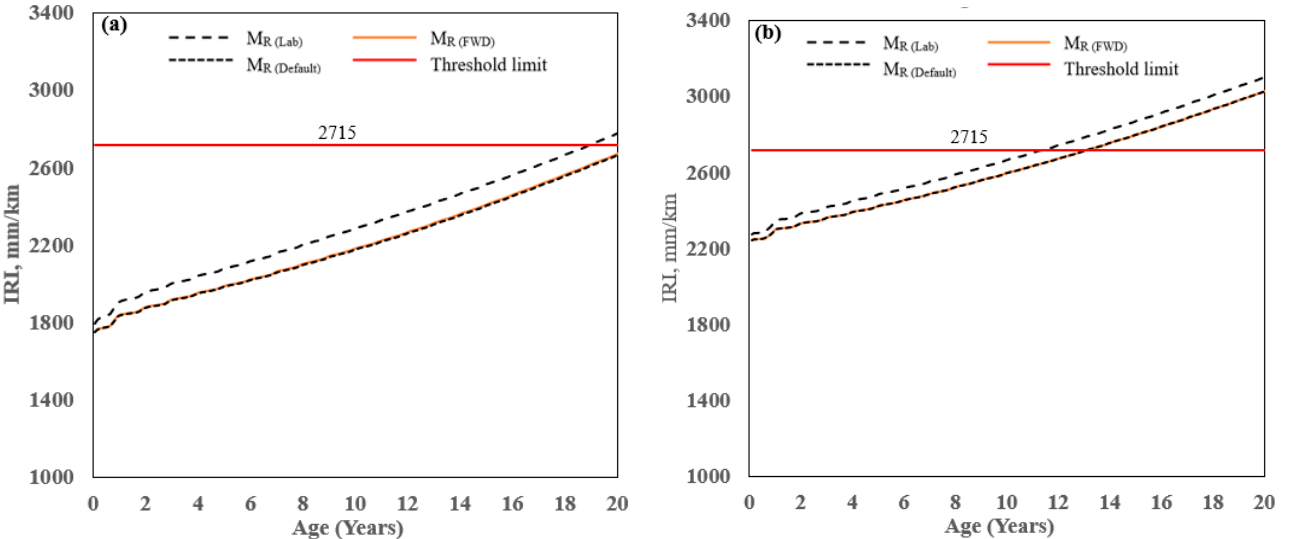
Figure 10. Predicted IRI: ( a ) Laurens/SC-72, and ( b )